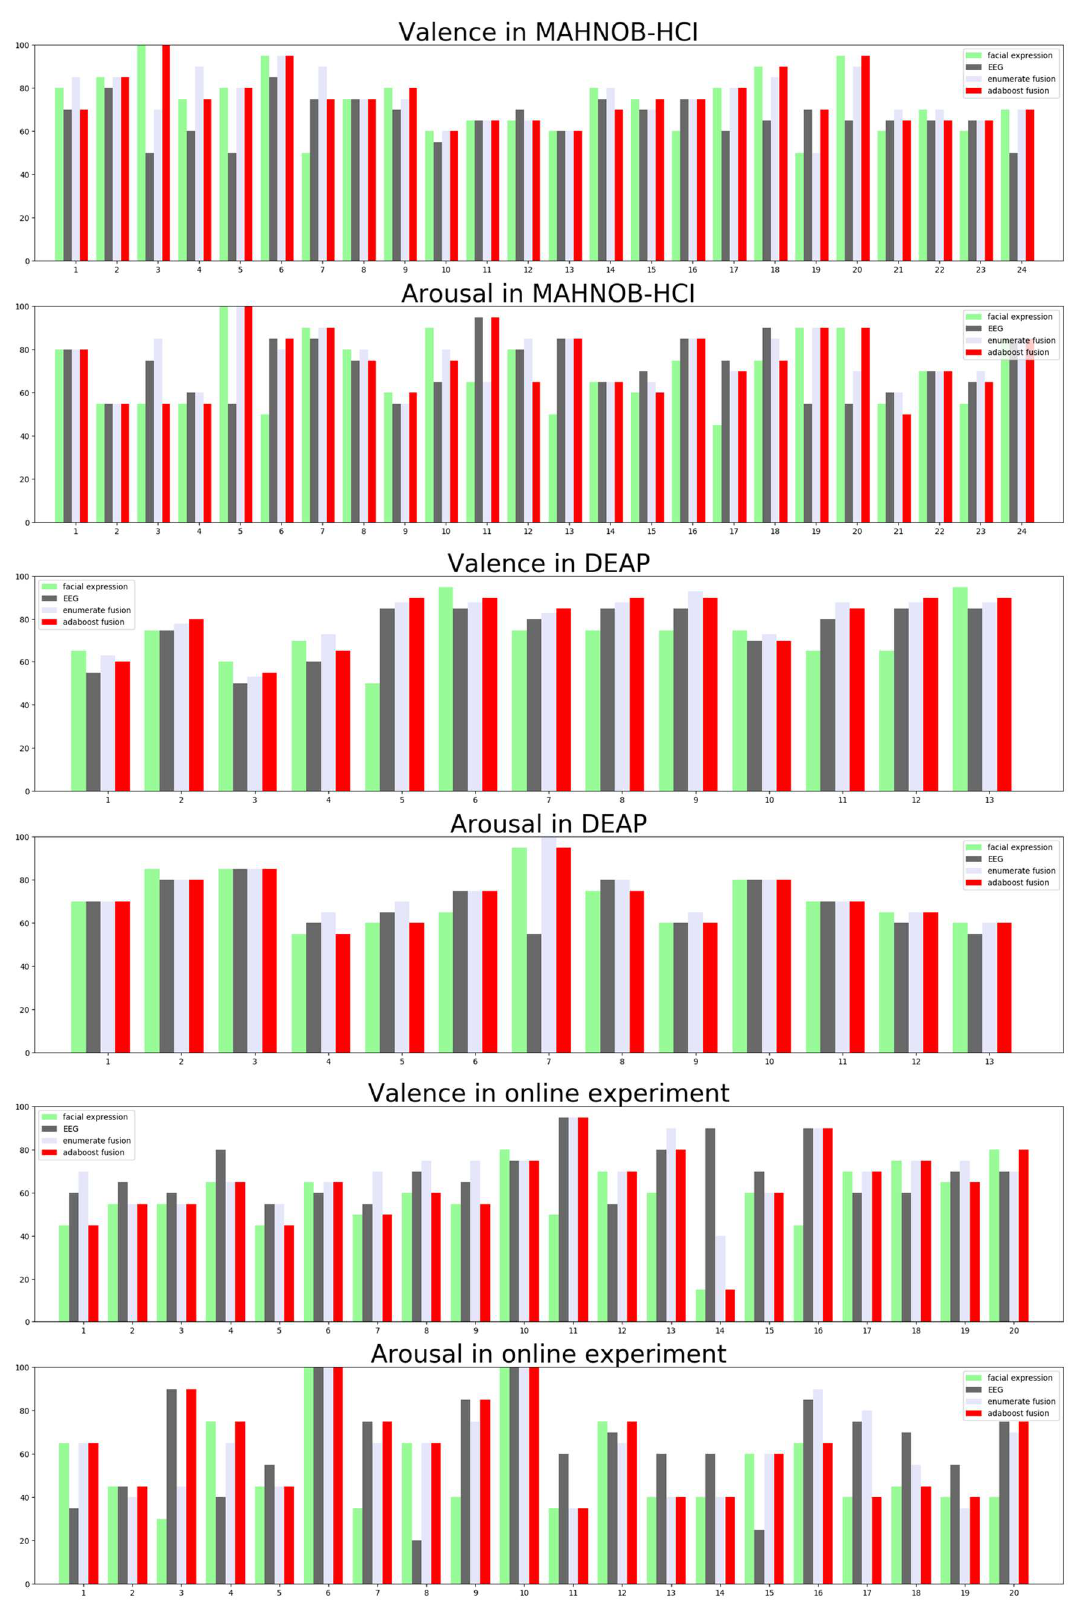
Figure 3. Accuracy of various subjects among various data sets. The X-axis of each sub-figure represents the subject I.D., and the Y-axis represents the accuracy.